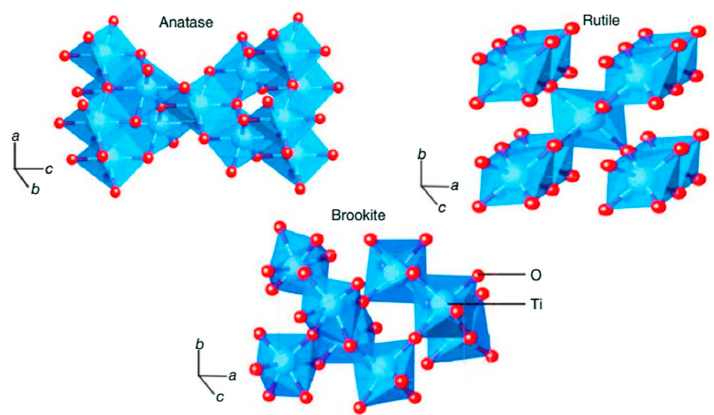
Figure 1. Different crystal structures of titanium dioxide (anatase, rutile and brookite). Reprinted with permission from ref. [32] WILEY Copyright 2019. Table 1. Crystal structure data of the three main polymorphs of TiO 2 [26,33,34].